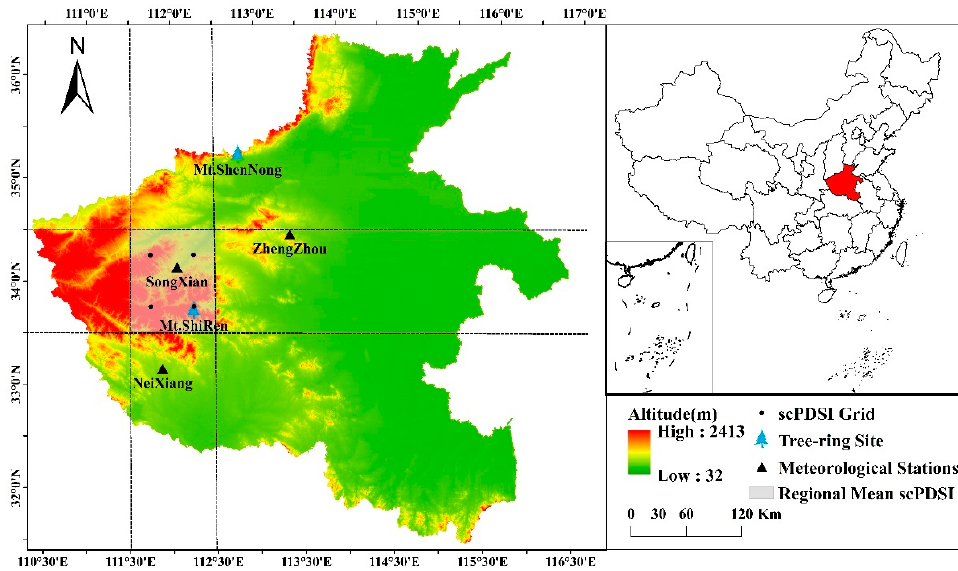
Figure 1. Map showing the study area (Mt. Shiren, 33 ° 43 ′ 39.49 ″ N, 112 ° 15 ′ 4.39 ″ E), Songxian and Neixiang meteorological stations, the scPDSI grid points and regional mean value, and two contrast sites (Mt. Shennong: tree-ring reconstruction site, Zhengzhou: historical document site).